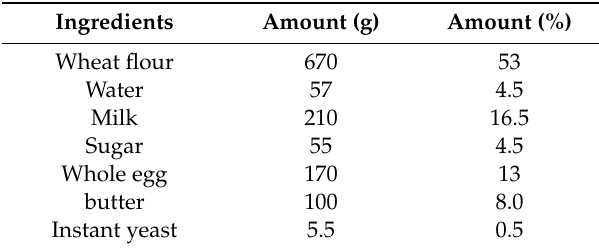
Table 5. Formulation of donut